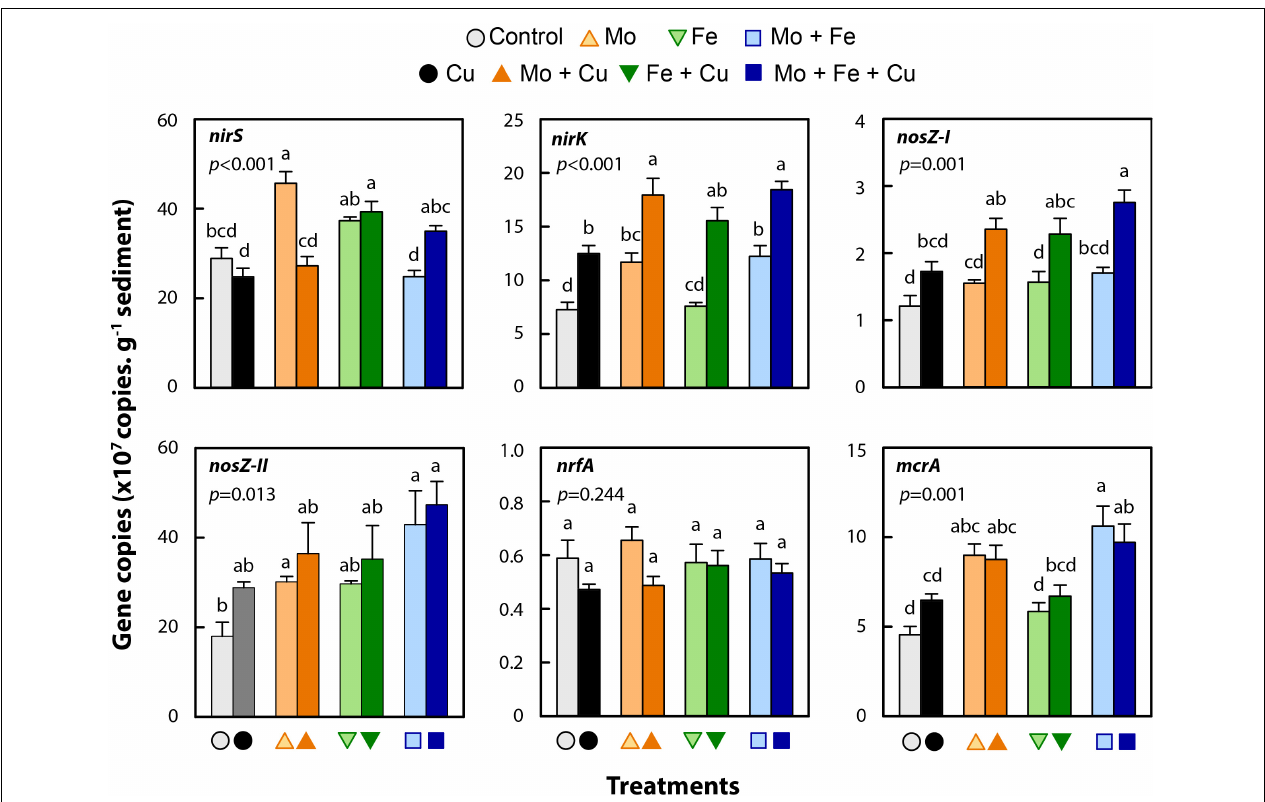
FIGURE 3 | Gene copies per g sediment (dry weight) at the end of incubation (96 h) in microcosms amended with molybdate (Mo), iron (Fe), copper (Cu), and combinations thereof. Genes were targeted representing nitrite reducers ( nirS , nirK, and nrfA ), nitrous oxide reducers ( nosZ-I and II ), and methanogens ( mcrA ). Data are shown as mean ± standard error ( n = 4). Letters within each bar graph indicate significant differences as determined by Kruskal–Wallis and Bonferroni post hoc